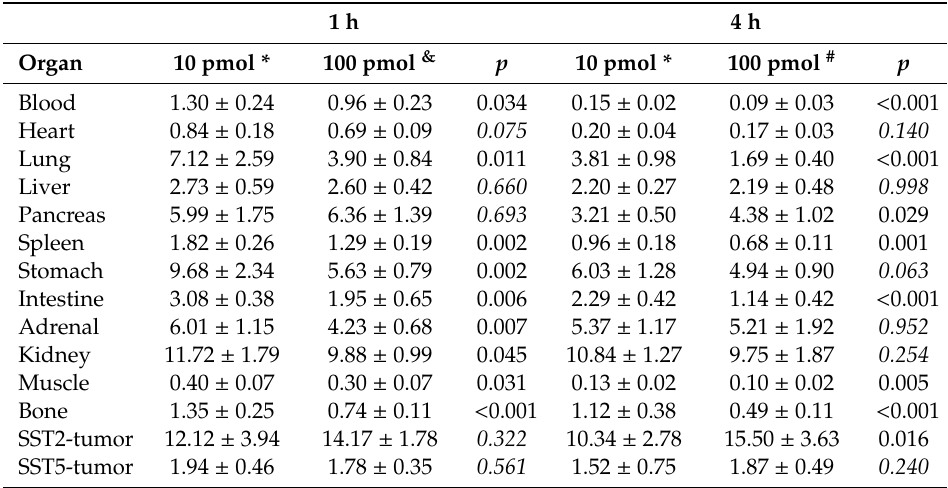
Table 3. Biodistribution results of 10 vs. 100 pmol [ 177 Lu]Lu-DOTA-ST8950 on dual SST2- and SST5-expressing xenografts at 1 and 4 h p.i. The results are expressed as mean of the % injected activity per gram of tissue (%IA / g) ± standard deviation